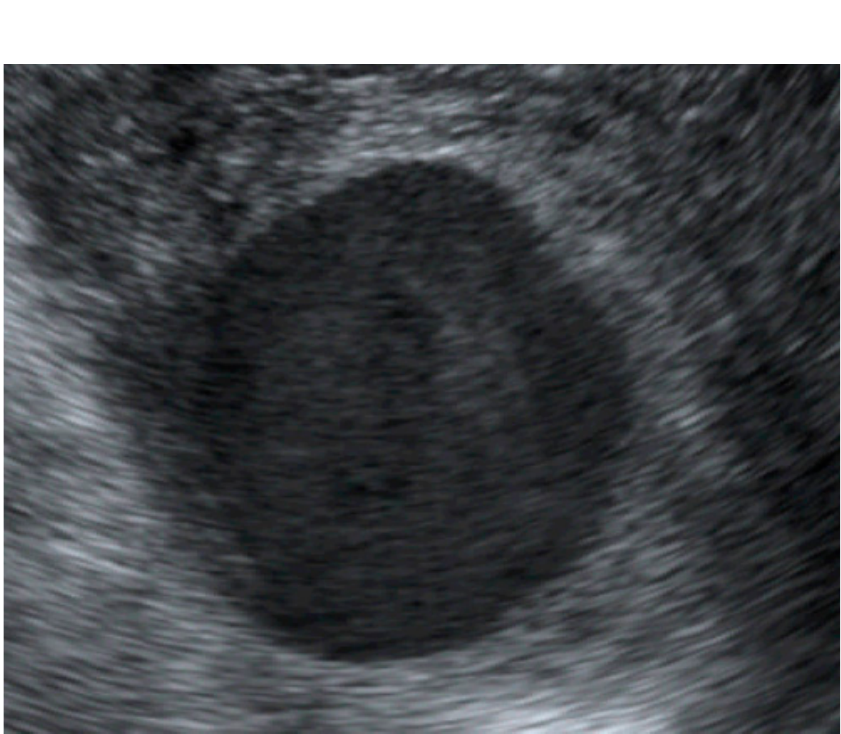
Figure 1. and Video S1: A 32-year-old primigravid woman underwent obstetric ultrasound at 32 weeks of gestation because of a small-for-date uterine size. Her medical history as well as familial history was unremarkable; no underlying medical disease and no history of any pelvic surgery.